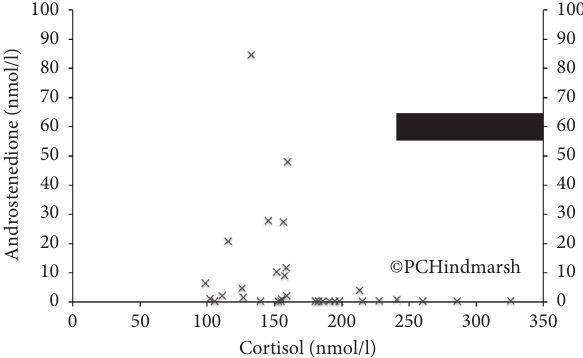
Figure 5: Relationship between plasma androstenedione con- centration and 24-hour mean plasma cortisol concentration in 34 children with salt-wasting congenital adrenal hyperplasia showing step effect at 150nmol/l. The black bar shows the normal range of 24-hour mean plasma cortisol concentrations (drawn at 20-minute intervals over 24 hours) in 80 normal adult individuals (aged between 60 and 70 years; see [2]). Reproduced from Congenital Adrenal Hyperplasia: A Comprehensive Guide, Hindmarsh P and Geertsma K Elsevier, New York